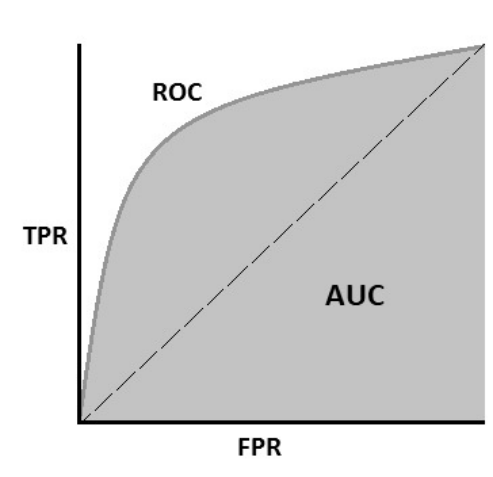
Figure 1. AUC - ROC Curve.